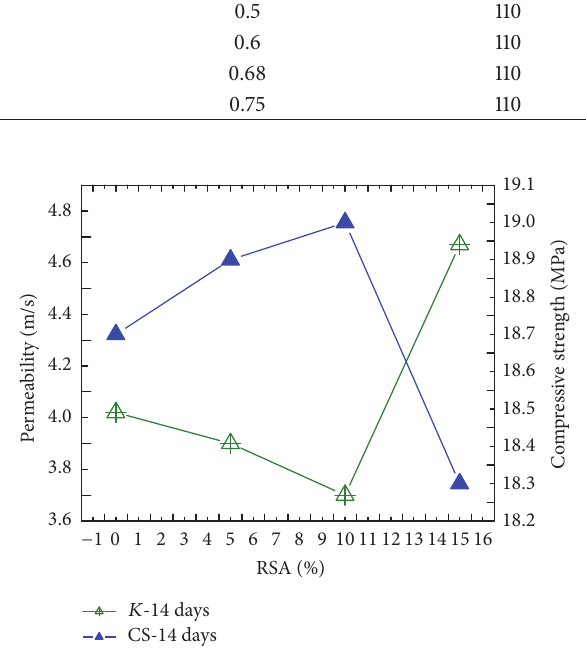
Figure 11: Relationship between K and CS at 14